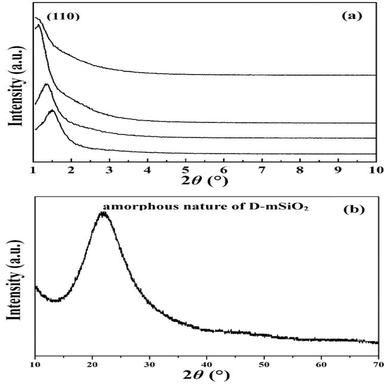
Small-angle (a) and low-angle (b) XRD patterns of D-mSiO2 samples.